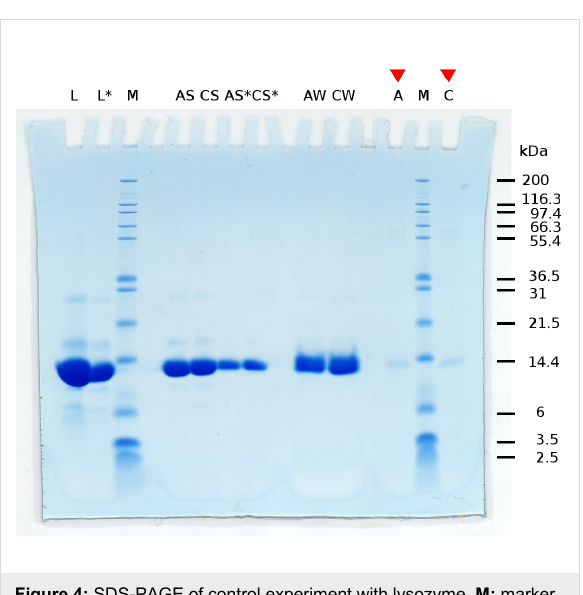
Figure 4: SDS-PAGE of control experiment with lysozyme. M: marker proteins of known size. L , L*: high concentrated lysozyme solution, at two different concentrations. AS , CS, AS* , CS*: supernatant of incu- bated aragonite and calcite crystals, at two different concentrations. AW , CW: combined washings of aragonite and calcite. A , C: acetic acid dissolved crystals after dialysis in sodium citrate buffer. Comparing bands in lanes A and C shows no difference in